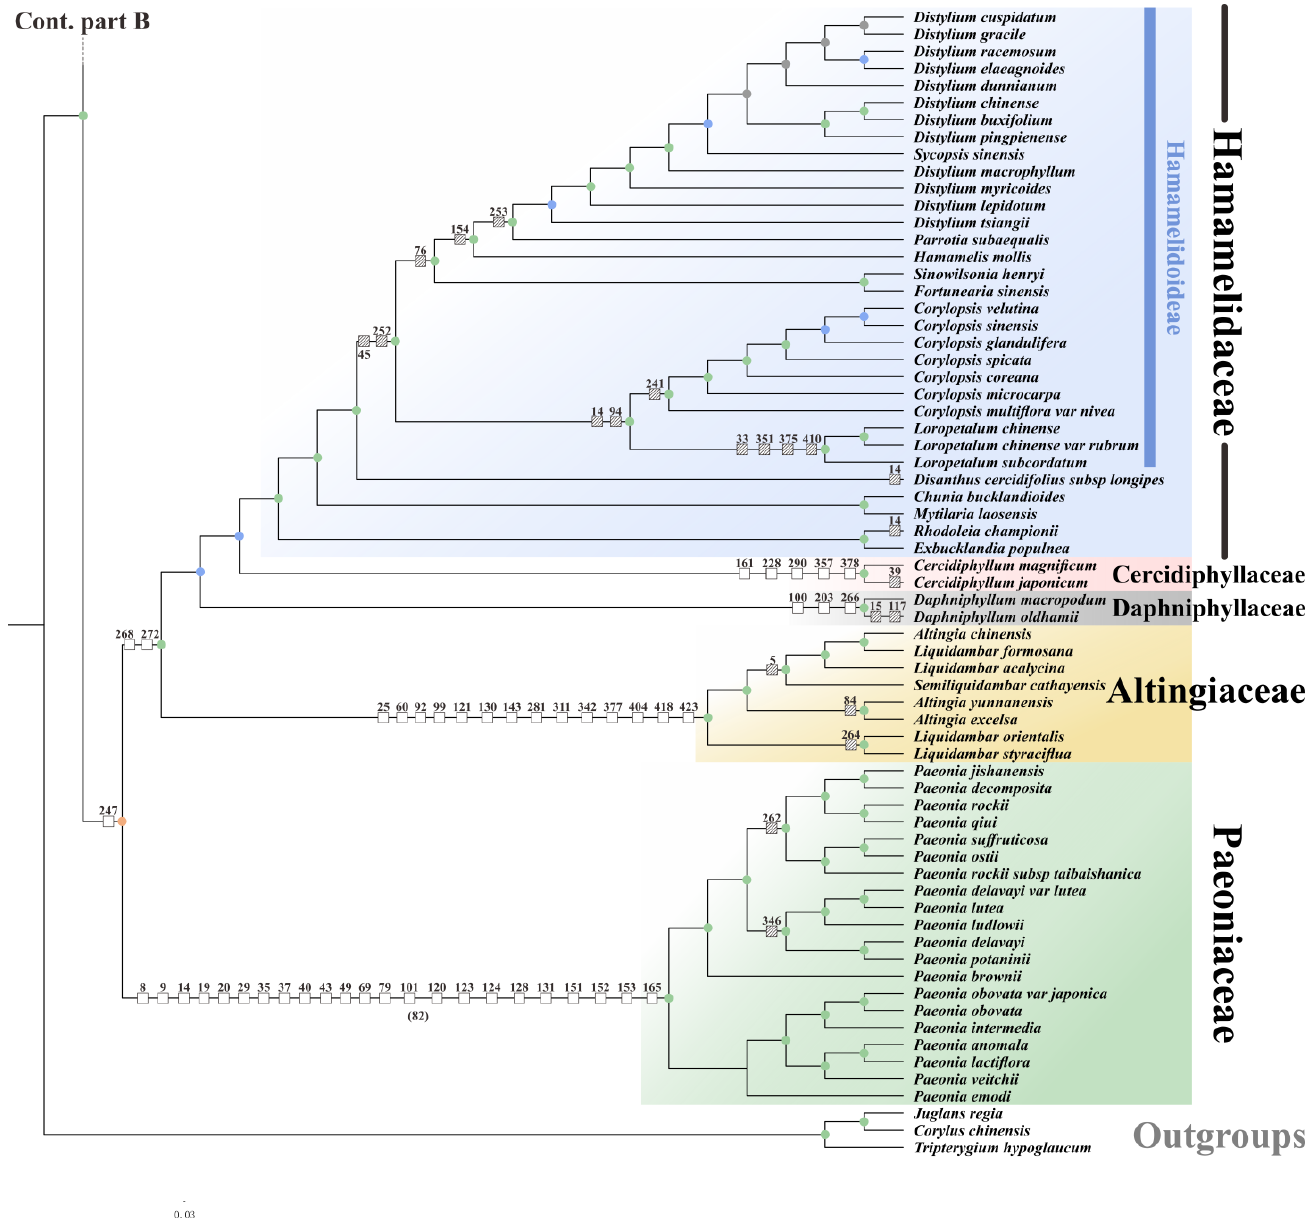
Figure 3. The phylogenetic tree obtained by 79 PCGs among 208 Saxifragales plastomes, with BS and PP values shown by color circles. White boxes indicate the specific indels for deep-level nodes. Lined boxes indicate the specific indels for lower-level nodes. As those clades with too many specific indels were limited in branch lengths, we marked as many indels as possible, and the total number was noted under the corresponding clade.